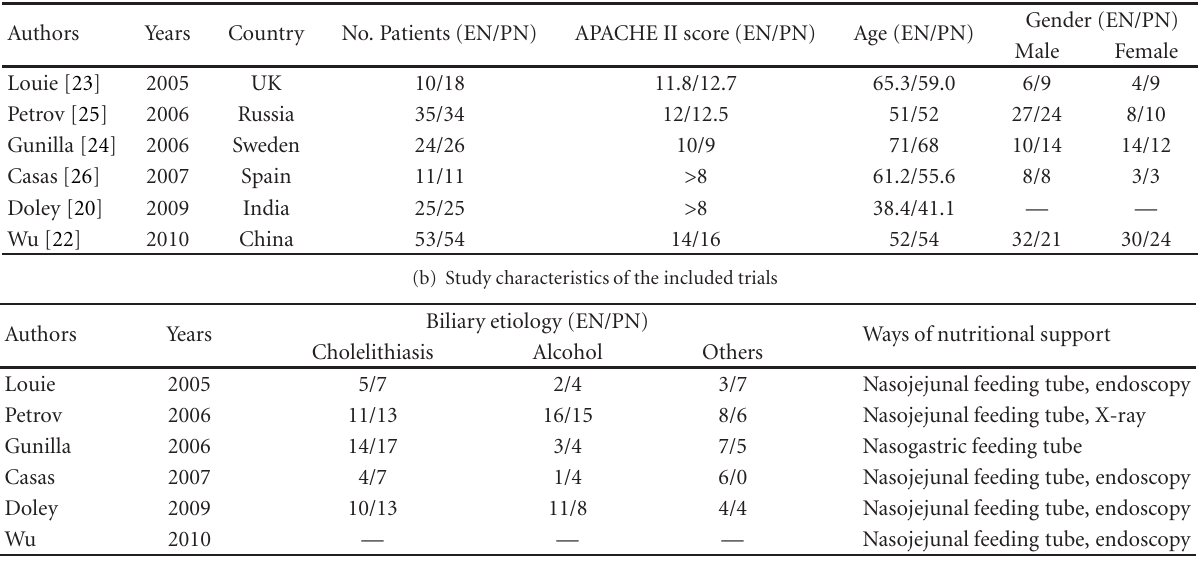
(a) Study characteristicsof the included trials